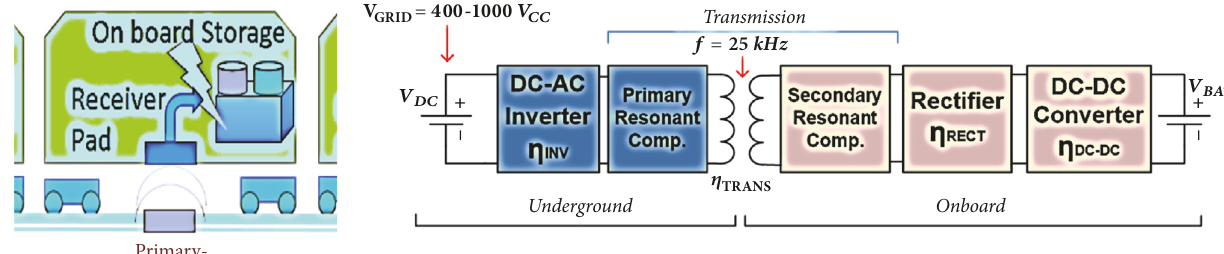
Figure 2: Proposed wireless, static recharge system.